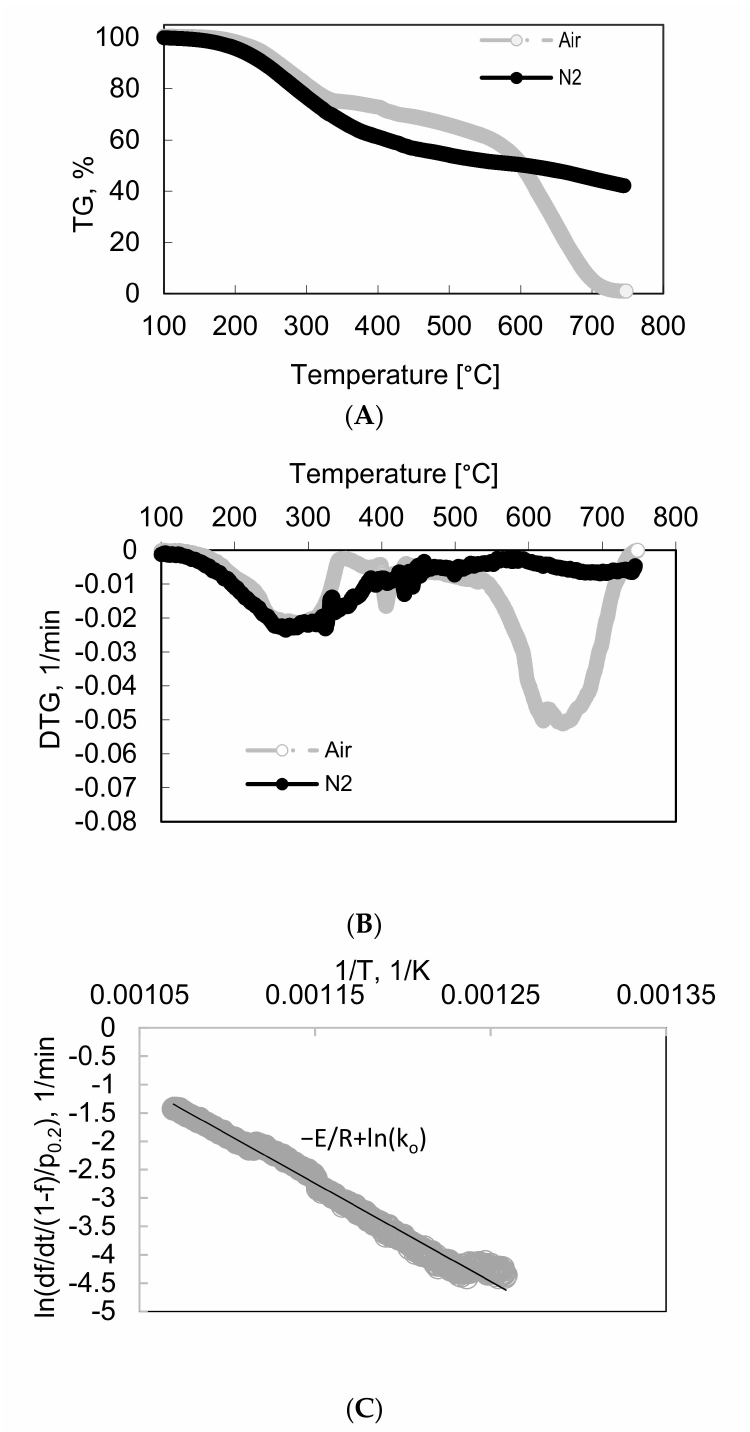
Figure 12. A:TG ( A ) and DTG ( B ) curves of a petroleum pitch (see PP118 in [52]) in Nitrogen and in air at constant heating rate of 10 K/min. ( C ): Arrhenius plot of the combustion stage from Pitch NI-TGA in